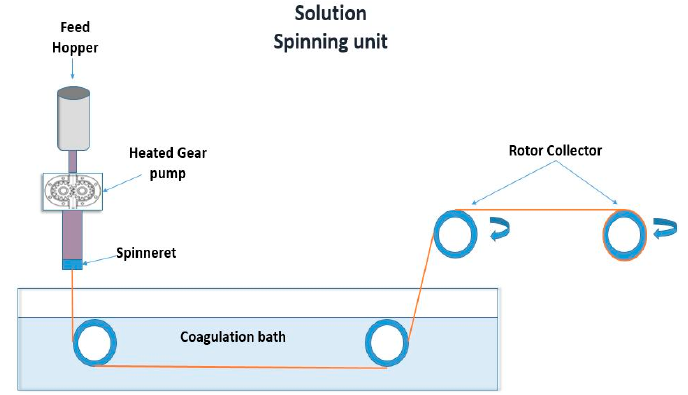
Figure 1. Laboratory solution spinning line.